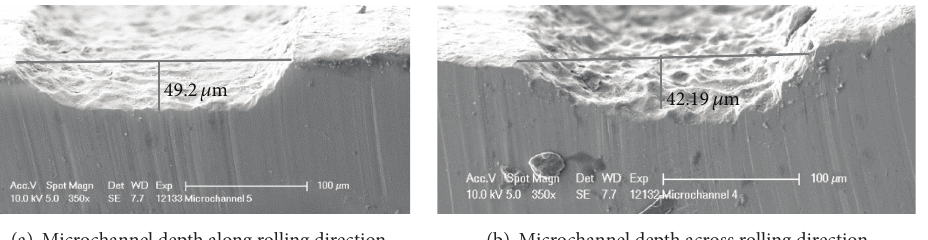
Figure 5: Effect of rolling direction on depth of etch.